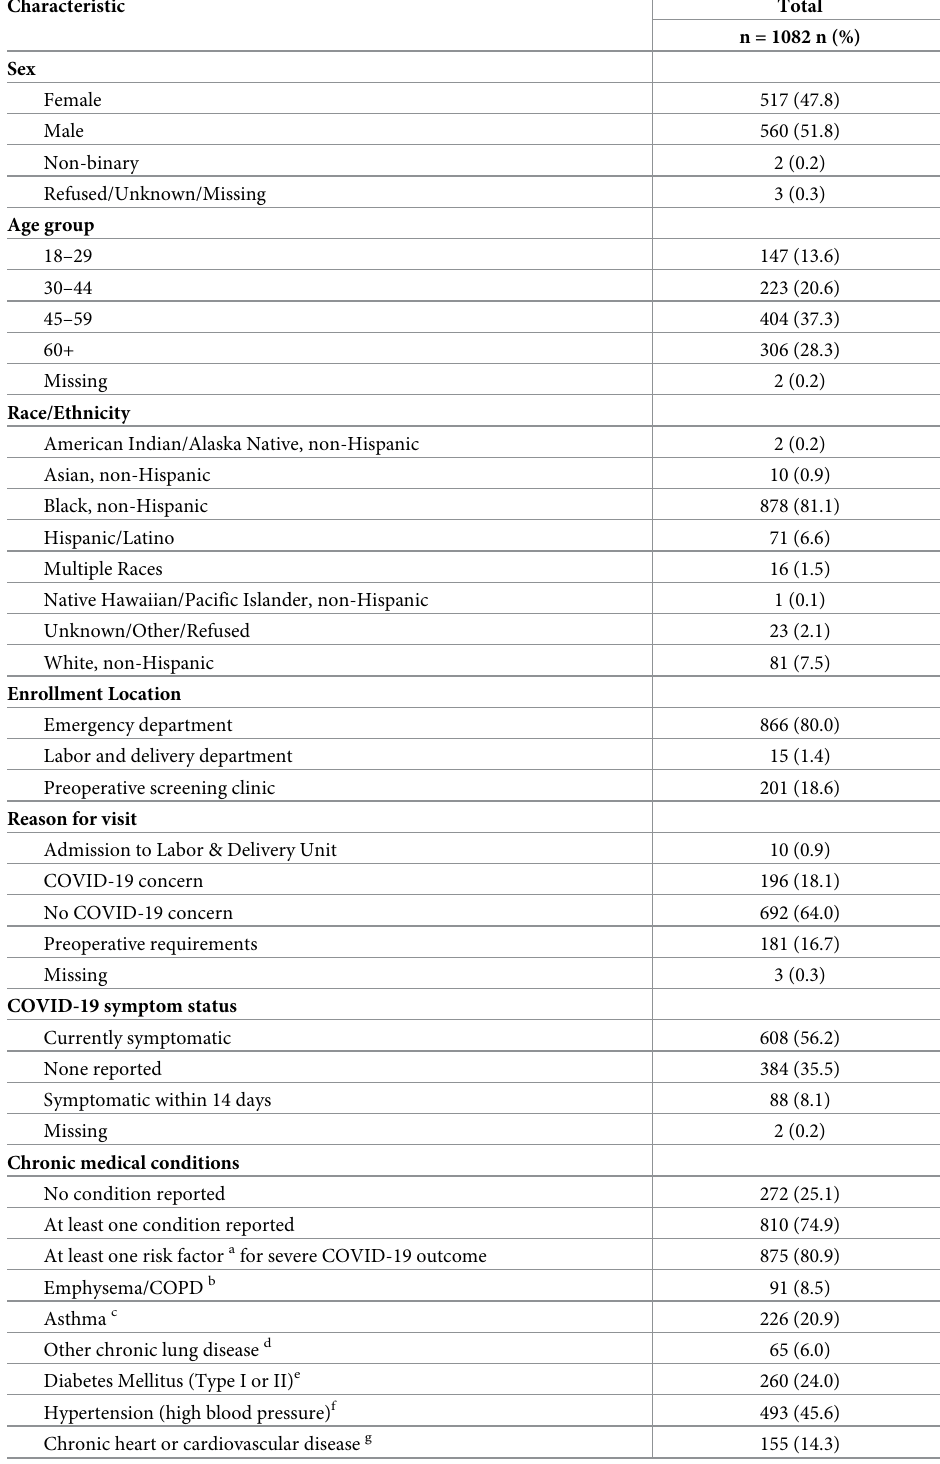
Table 1. Characteristics and reported symptoms of participants who contributed self-collected saliva and anterior nasal swabs for SARS-CoV-2 detection by RT-PCR at Grady Memorial Hospital—Atlanta, GA, August–October